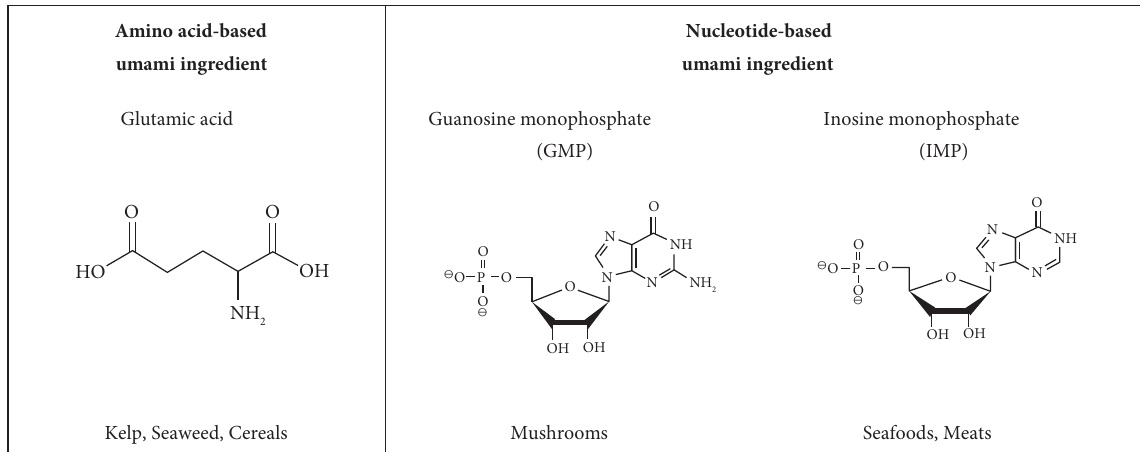
Figure 2: Types of umami ingredients—representative source and chemical